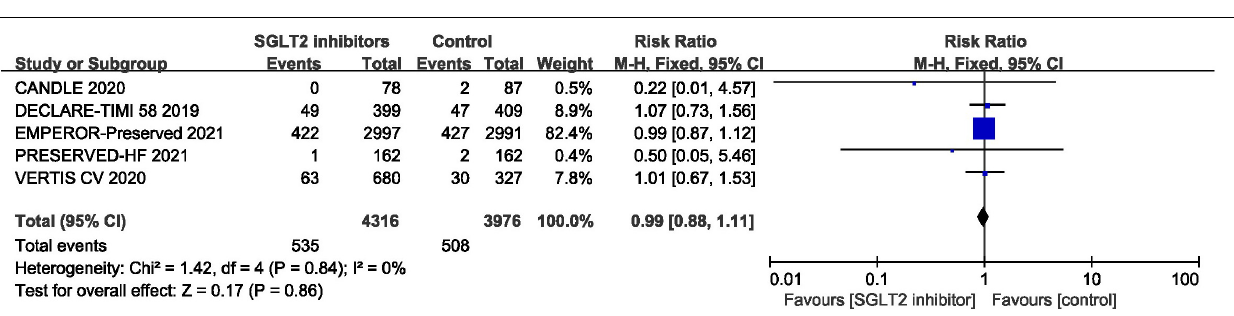
FIGURE 9 | Forest plot displaying the effects of SGLT2 inhibitors vs. placebo for all-cause mortality in HFpEF patients.